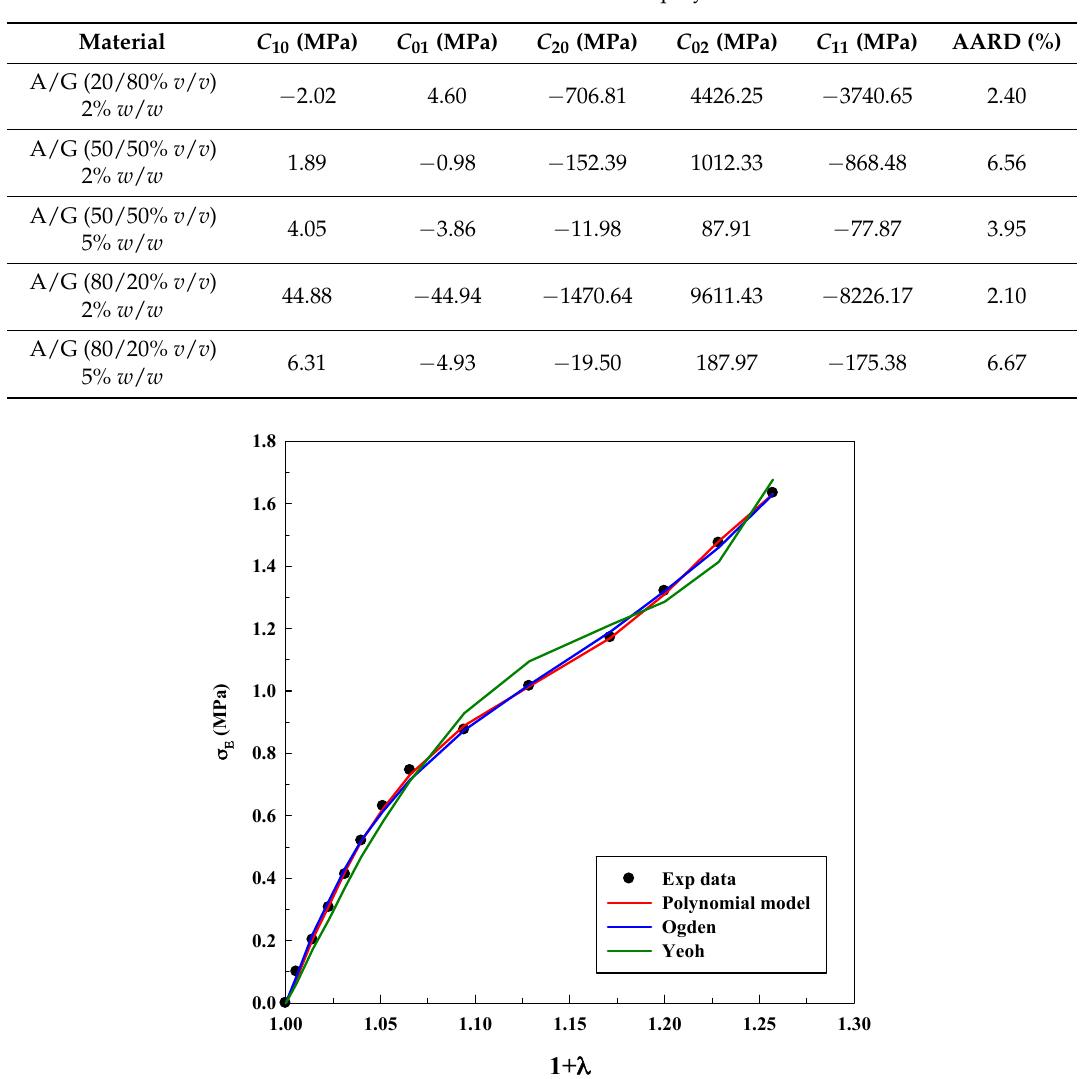
Table 3. Parameters and deviations for the polynomial model.